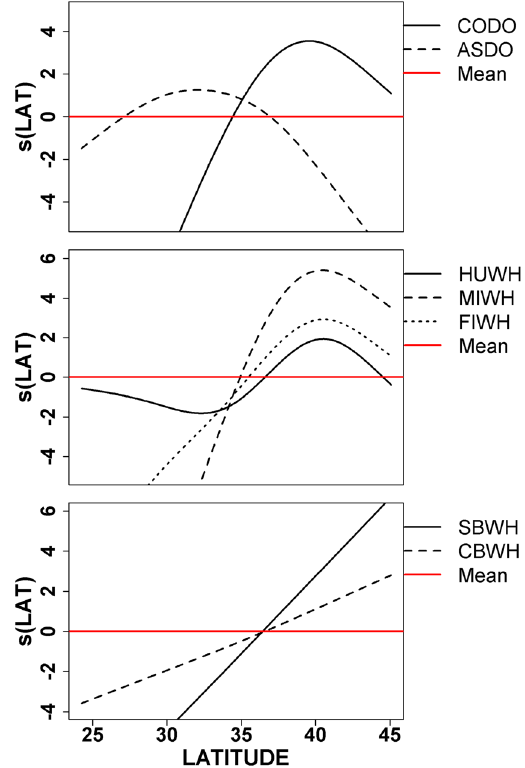
Figure 3. Examples of the partial effect of latitude on the changes in abundance relative to its mean for common dolphin (CODO), Atlantic spotted dolphin (ASDO), humpback whale (HUWH), minke whale (MIWH), fin whale (SEWH), Sowerby’s beaked whale (SBWH) and Cuvier’s beaked whale